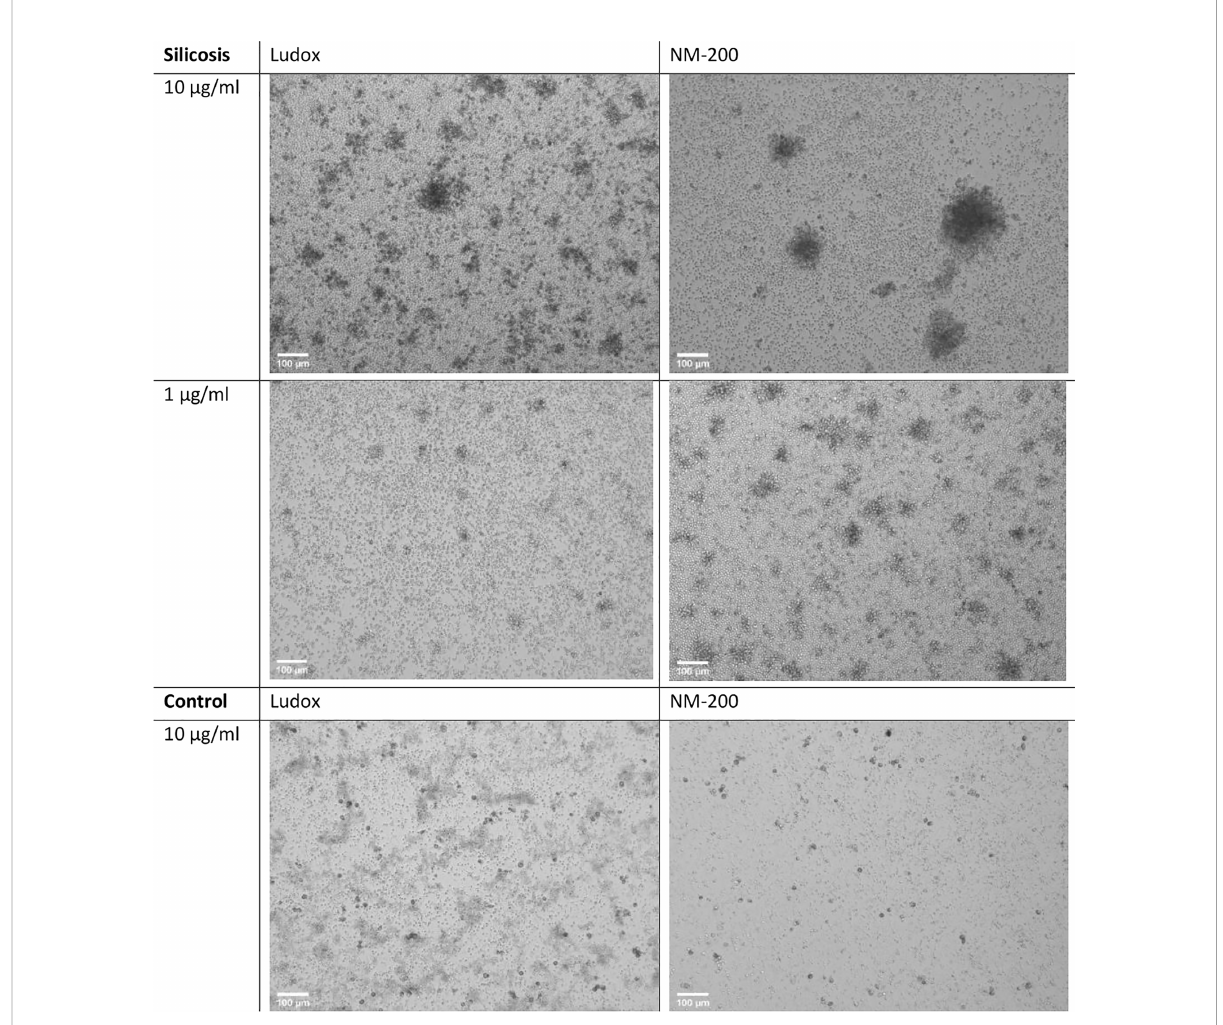
FIGURE 3 Microstructure of developing aggregates. PBMCs from silicotic patients and controls, were stimulated with Ludox and NM-200, with a starting concentration of 10 µg/ml. Representative images of day 7 (10x, EVOS) from 1 out of 12 images taken per well (replicate) from a single individual per group are included, scale bar: 100